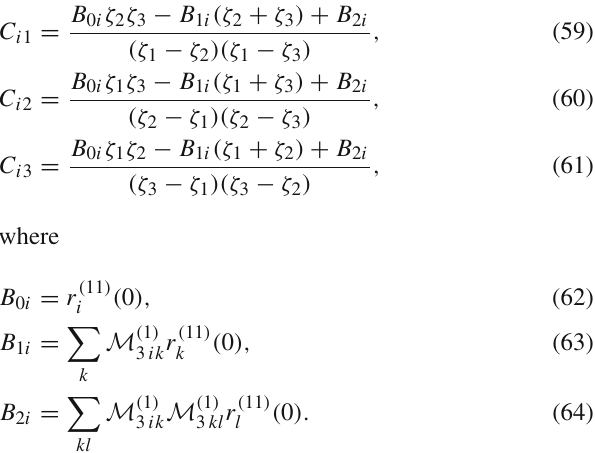
Fig. 1 The real root of the cubic equation (65) as a function of angular parameter β for different values of the reduced frequency